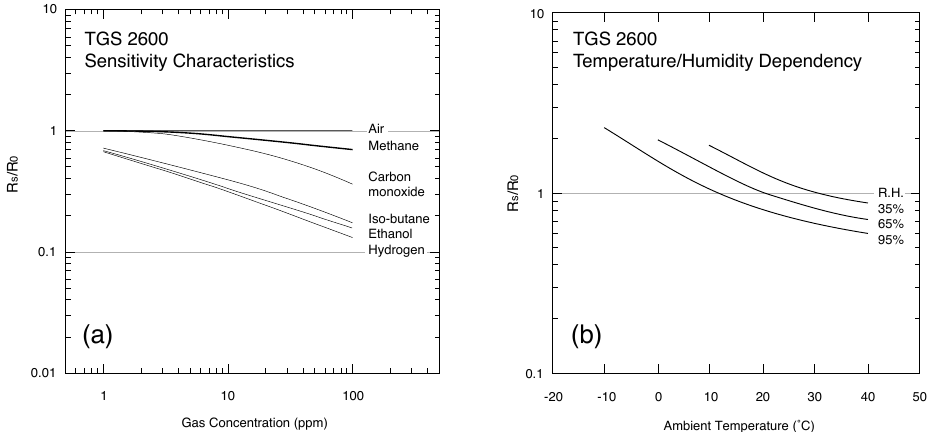
Fig. 1. General Figaro TGS 2600 sensor response (a) and sensitivity to temperature and relative humidity (b) according to manufacturer specifications. R s /R 0 is the ratio between sensor resistance ( R s ) under presence of a specific component in relation to the reference resistance ( R 0 ) in “fresh” air without any of the additional chemical components. Modified from Figaro (2005a).